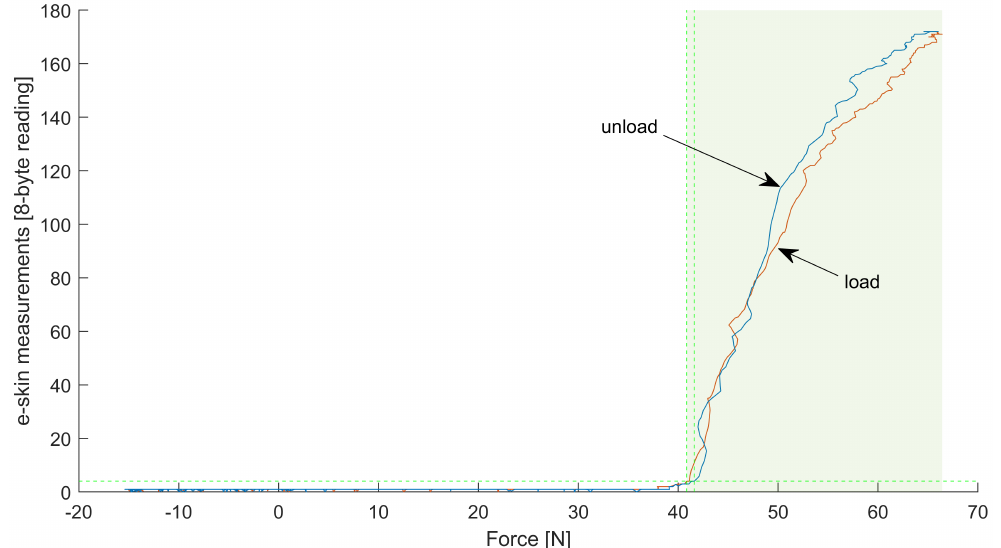
Figure 10. Data recorded while taking measurements from one of the e-skin sensors (row 7, col- umn 19)—data obtained from the e-skin sensor (abscissa) are plotted against data obtained from the Hex-e sensor (ordinate). Data acquired during the ‘loading’ phase are marked orange, and data acquired during the ‘unloading’ phase are marked blue. The green, horizontal, dashed line is a threshold value based on which narrowing the data range was performed. A data subset used during further processing is indicated by a green shaded area, limited by green, vertical, dashed lines localised in intersections of the threshold line and the e-skin